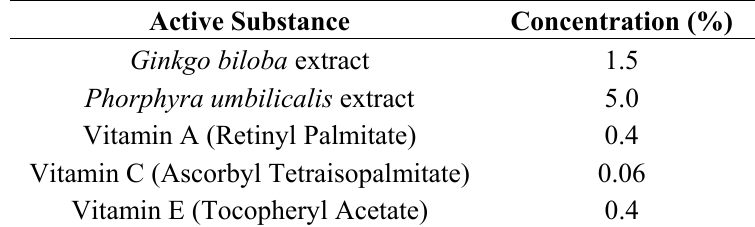
Table 1. Concentration of the active substances used in the development of the multifunctional cosmetic